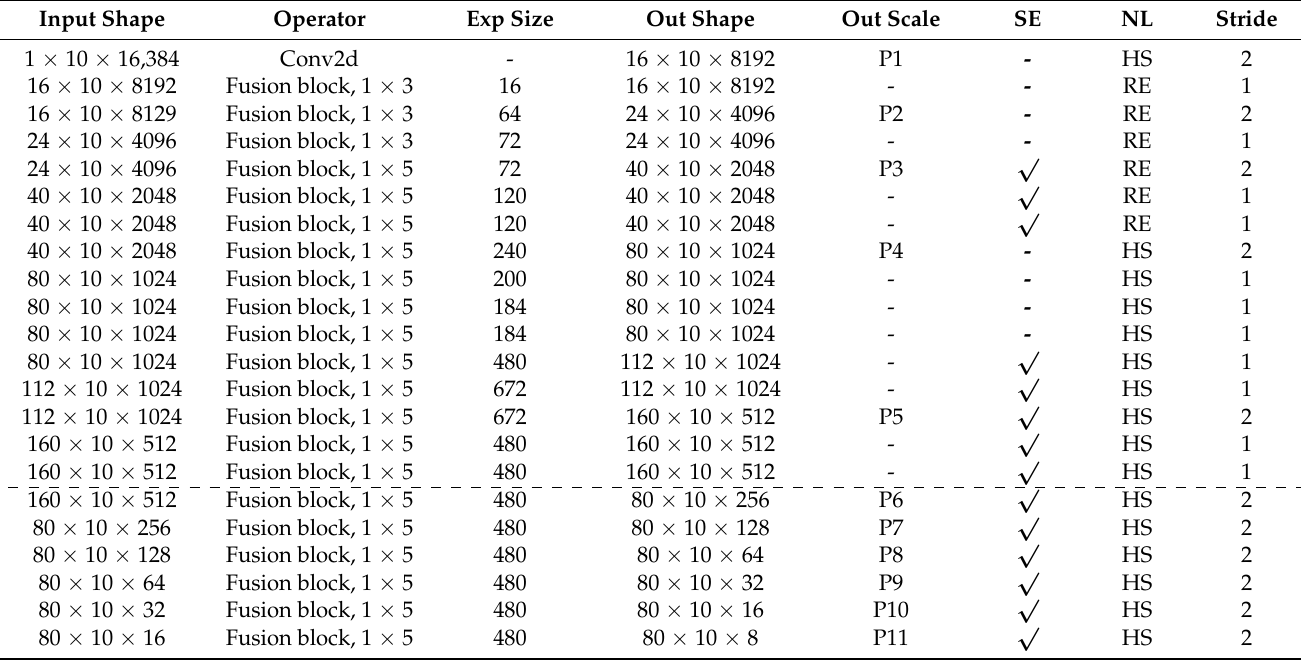
Table 1. Specification for the FFSCN-FMN backbone